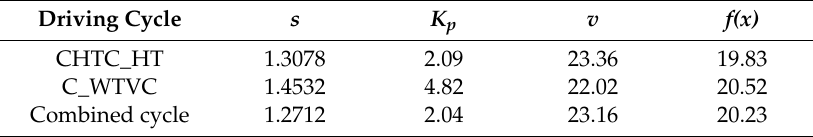
Table 5. The optimal parameters of ECMS under three driving cycles.